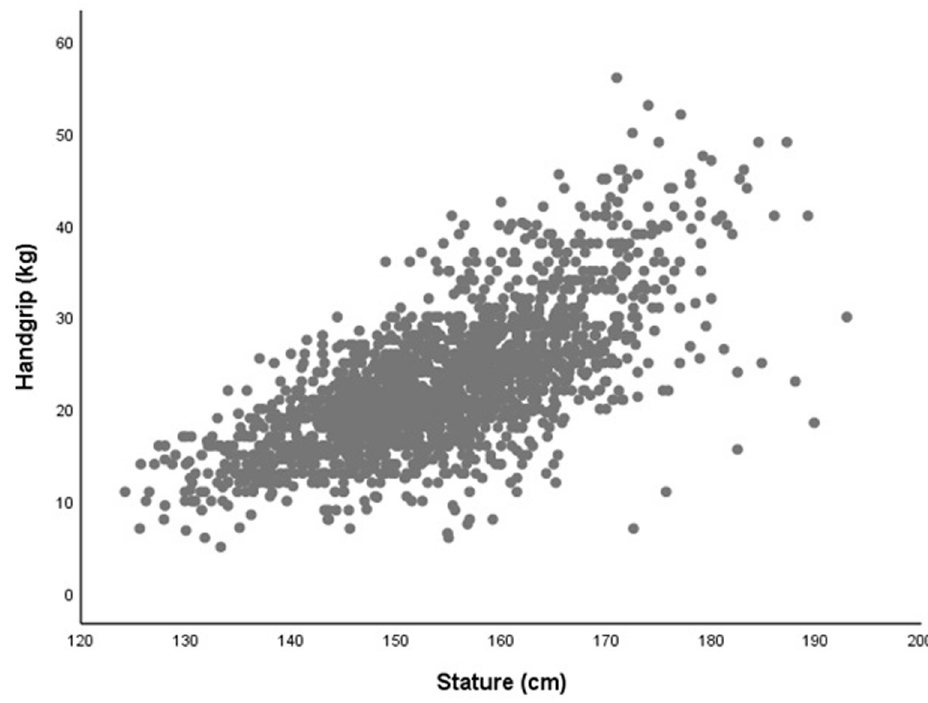
Fig 1. Association of handgrip strength and stature in English and Tanzanian schoolchildren (10.0–15.9 years). Handgrip (kg) assessed as highest value from three trials using the dominant hand. Stature (m) included as an index of overall body